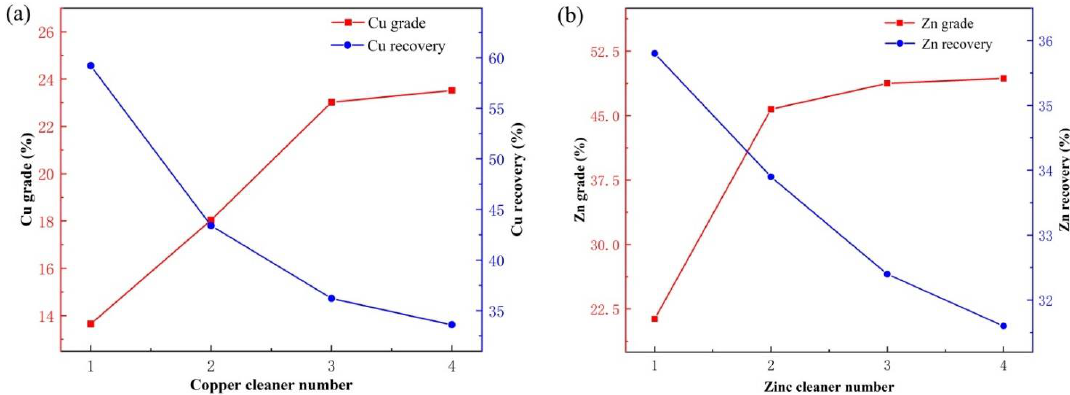
Figure 13. Effects of the number of cleaning cycles on copper ( a ) and zinc ( b ) flotations.